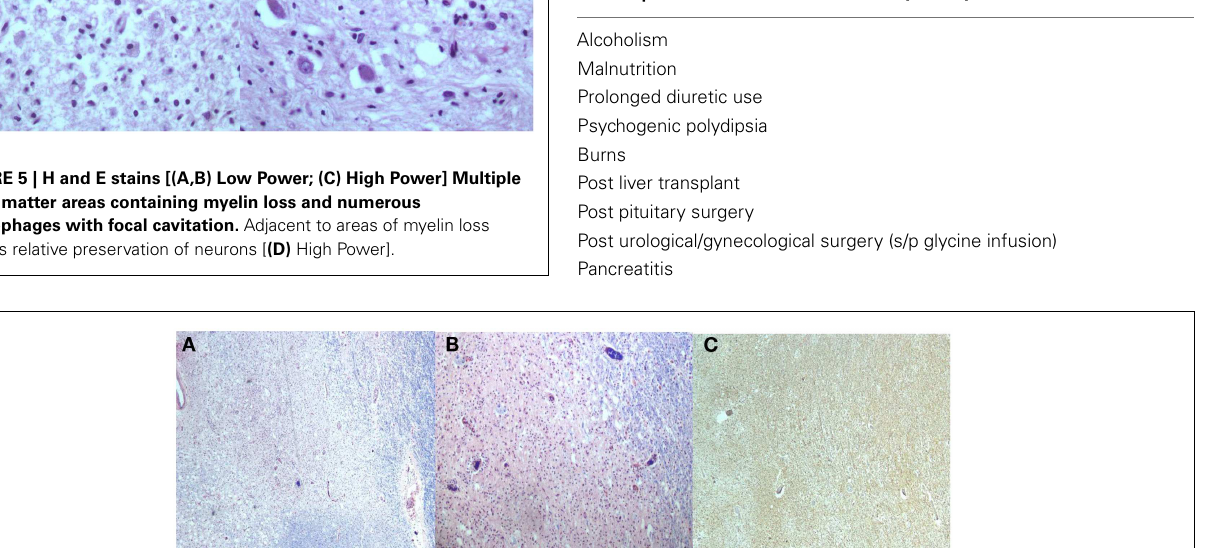
Table 2 | Disorders associated with